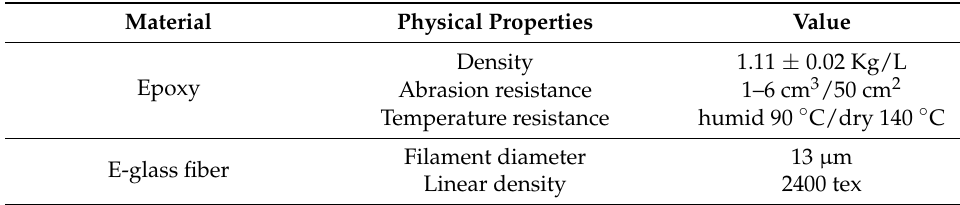
Table 1. The physical properties of the used materials.